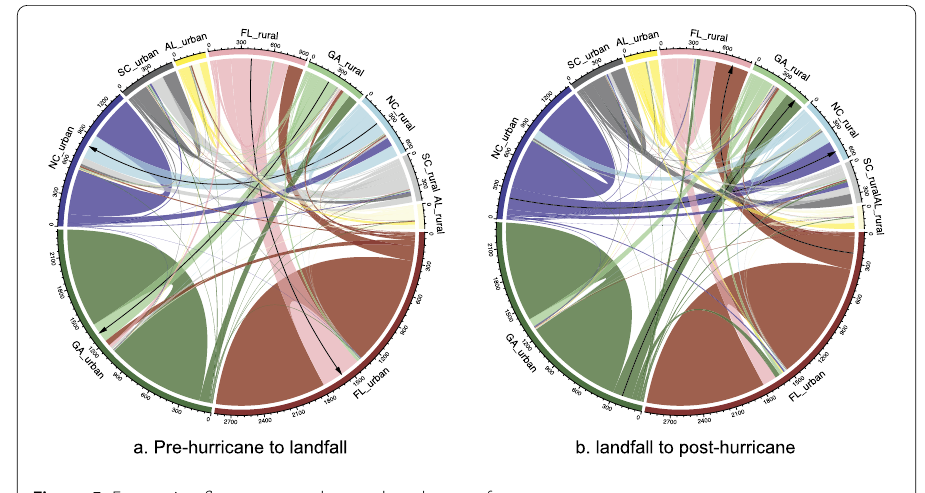
Figure 5 Evacuation flows across urban and rural areas of states